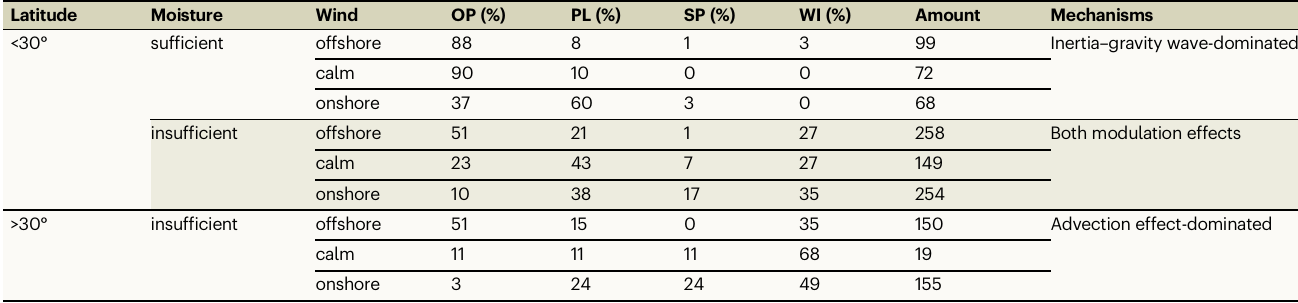
Table 1 | Combined in fl uences of the environmental factors on the diurnal pattern proportion Latitude Moisture